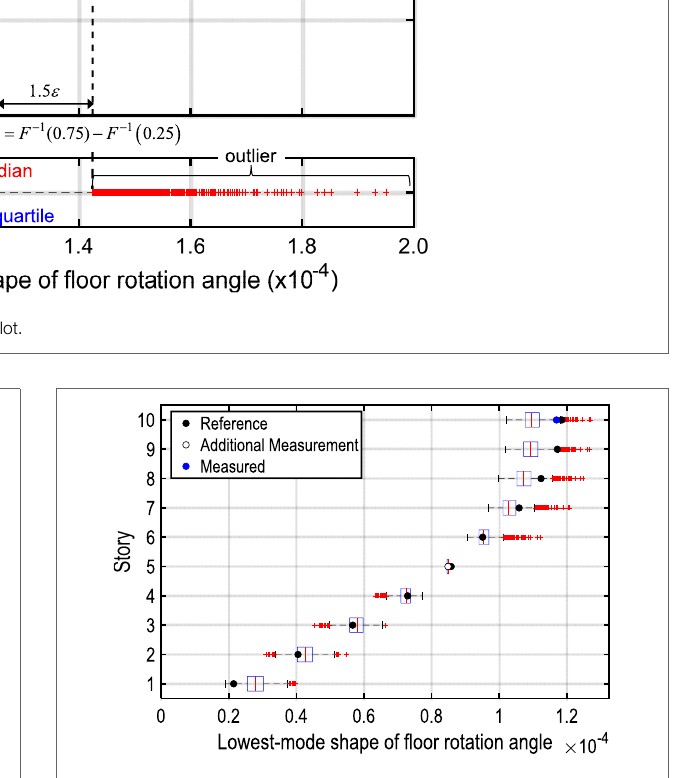
FIGURE 12 | Conditioning of probability distribution based on additional measurement